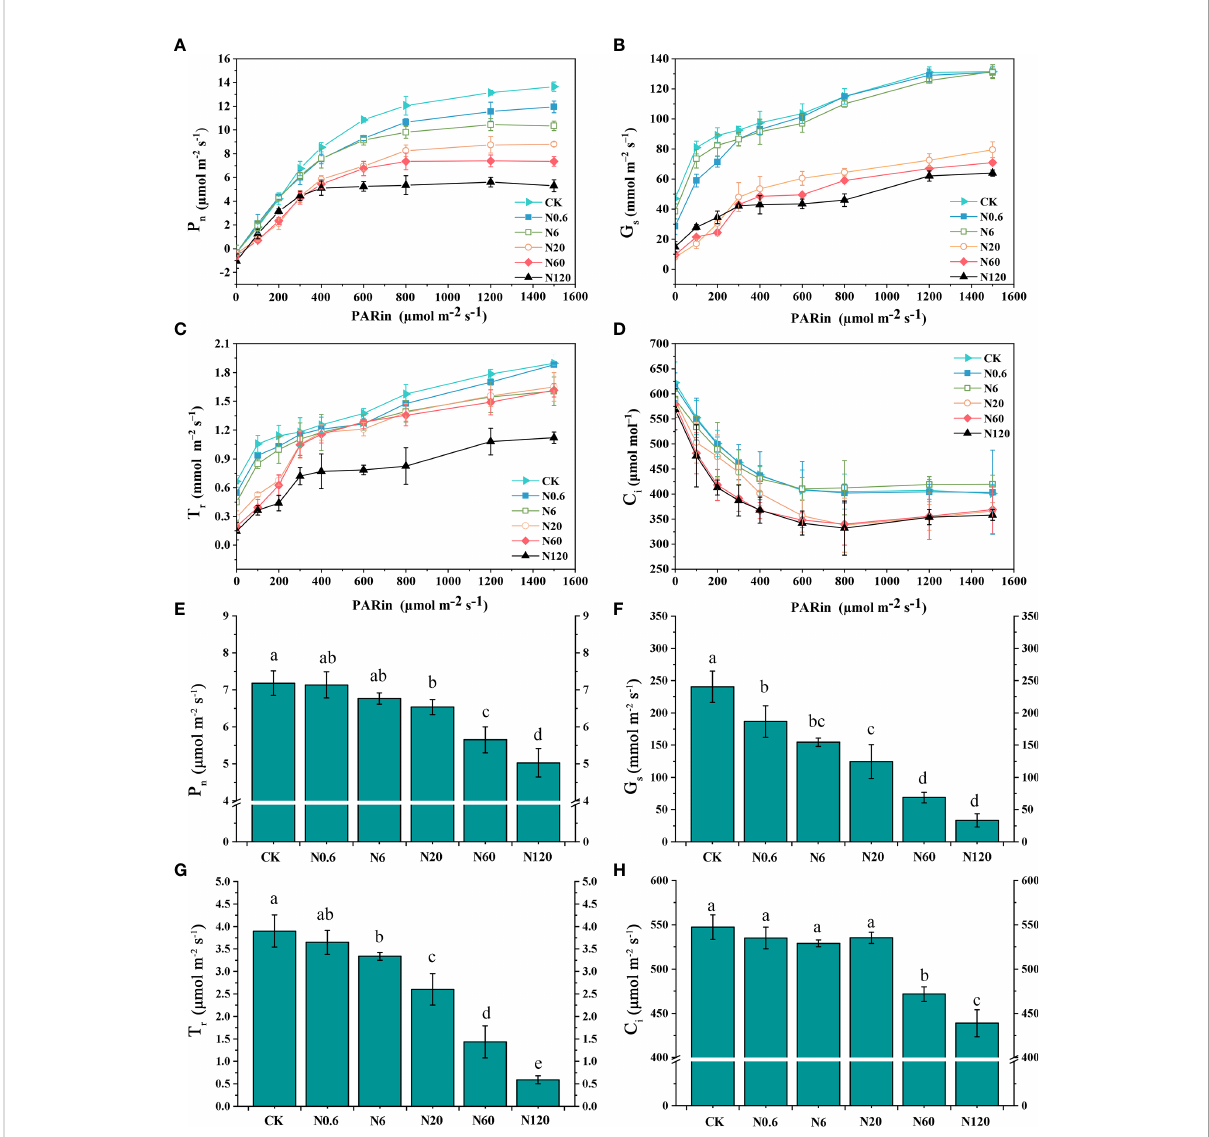
FIGURE 4 Effects of nicosulfuron on the gas exchange parameters of sugar beet leaf. P n -light curve (A) , G s -light curve (B) , T r -light curve (C) , C i -light curve (D) , Net photosynthetic rate (P n ) (E) , stomatal conductance (G s ) (F) , transpiration rate (T r ) (G) and intercellular CO 2 concentration (C i ) (H) in sugar beet on 20 DAT with different doses of nicosulfuron. Data with the different letters indicate signi fi cant differences between different doses of nicosulfuron drift (n = 6, p <